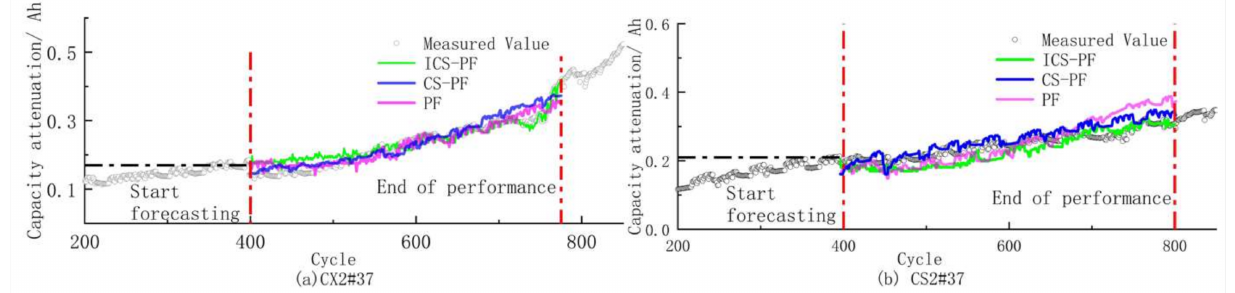
Figure 8. Comparation between two methods for CS2#37 and CX2#37 batteries. Table 4. State of health online estimation results evaluation.